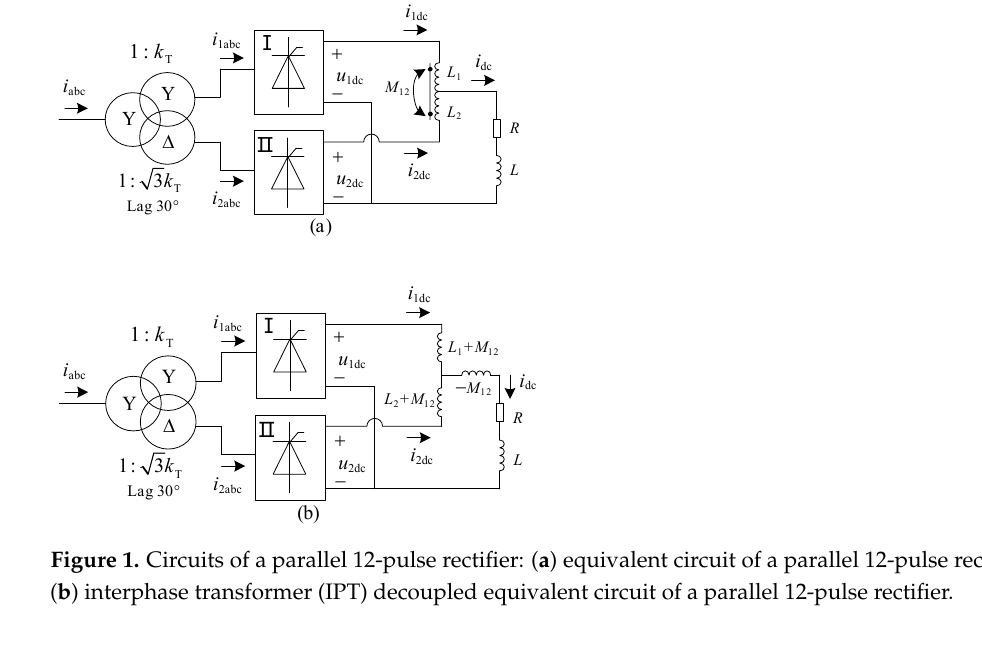
where: U 1dc0 and U 2dc0 are the average values of DC voltages of bridges I and II, and u 1dcn ( t ) and u 2dcn ( t ) are the DC voltage fluctuation components, respectively. In order to simplify the